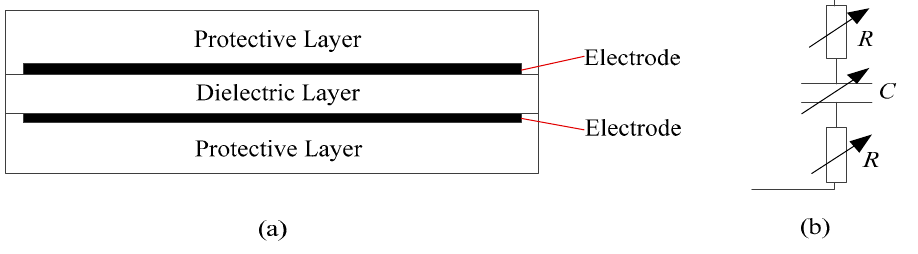
Figure 2. ( a ) Typical structure of the dielectric elastomer sensor (DES); ( b ) Equivalent circuit of the